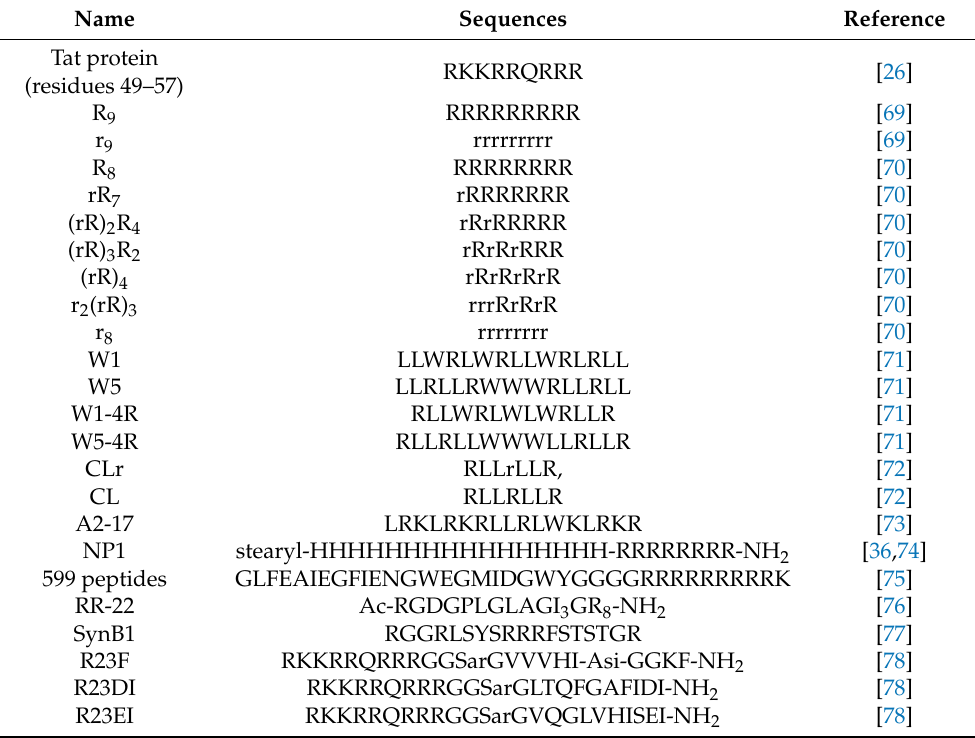
Table 1. Sequences and nomenclature of the CPPs used in the